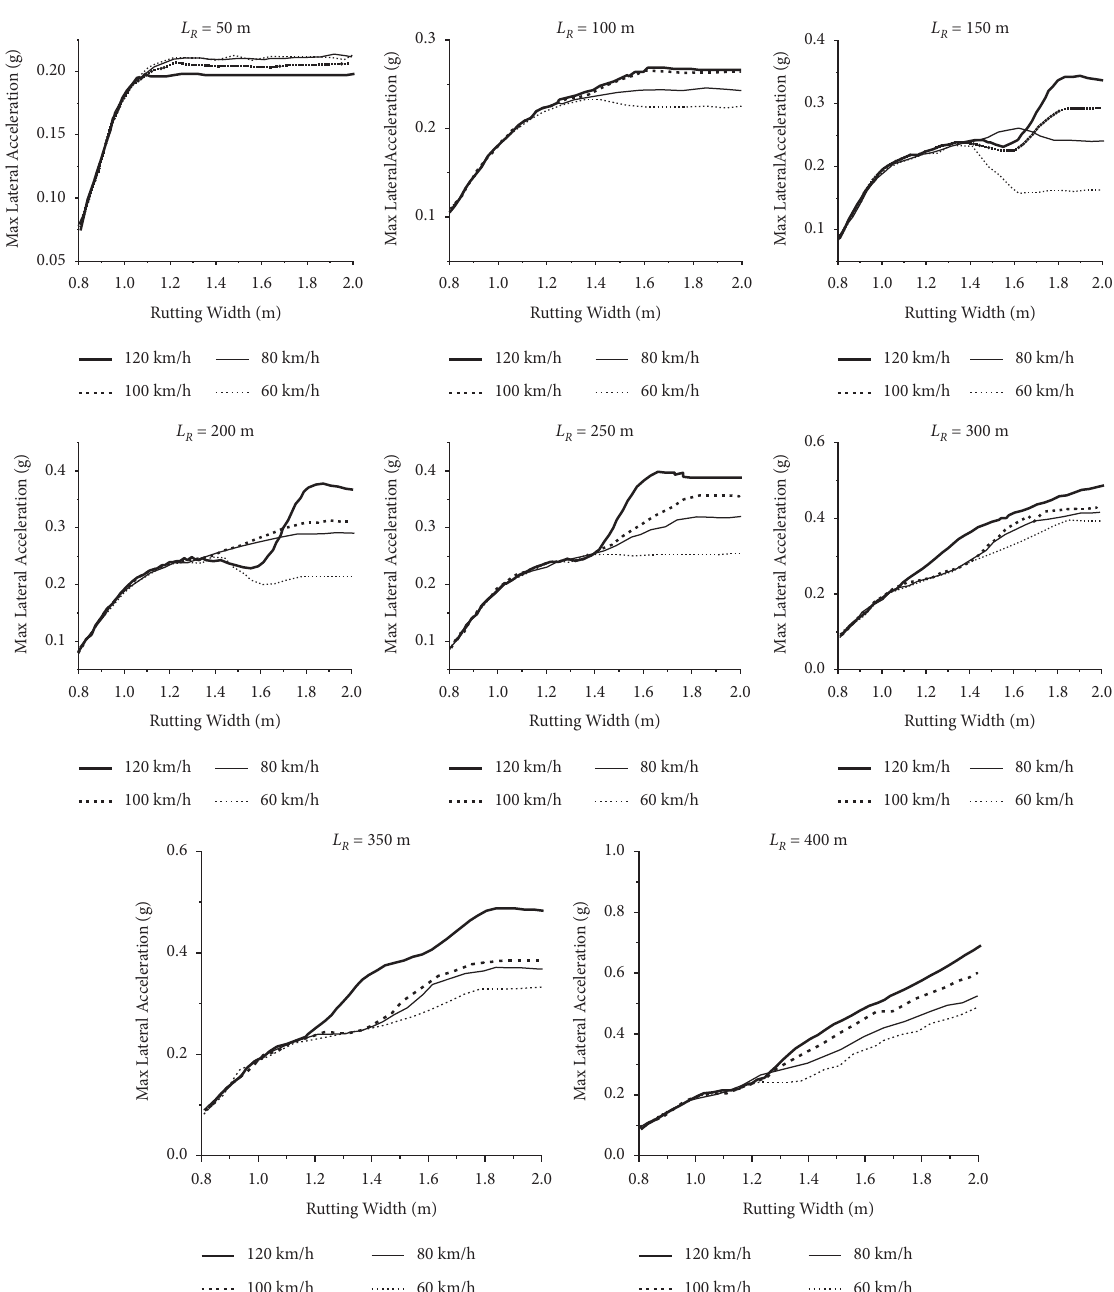
Figure 14: Maximum lateral acceleration at different combinations of water length and width ( L